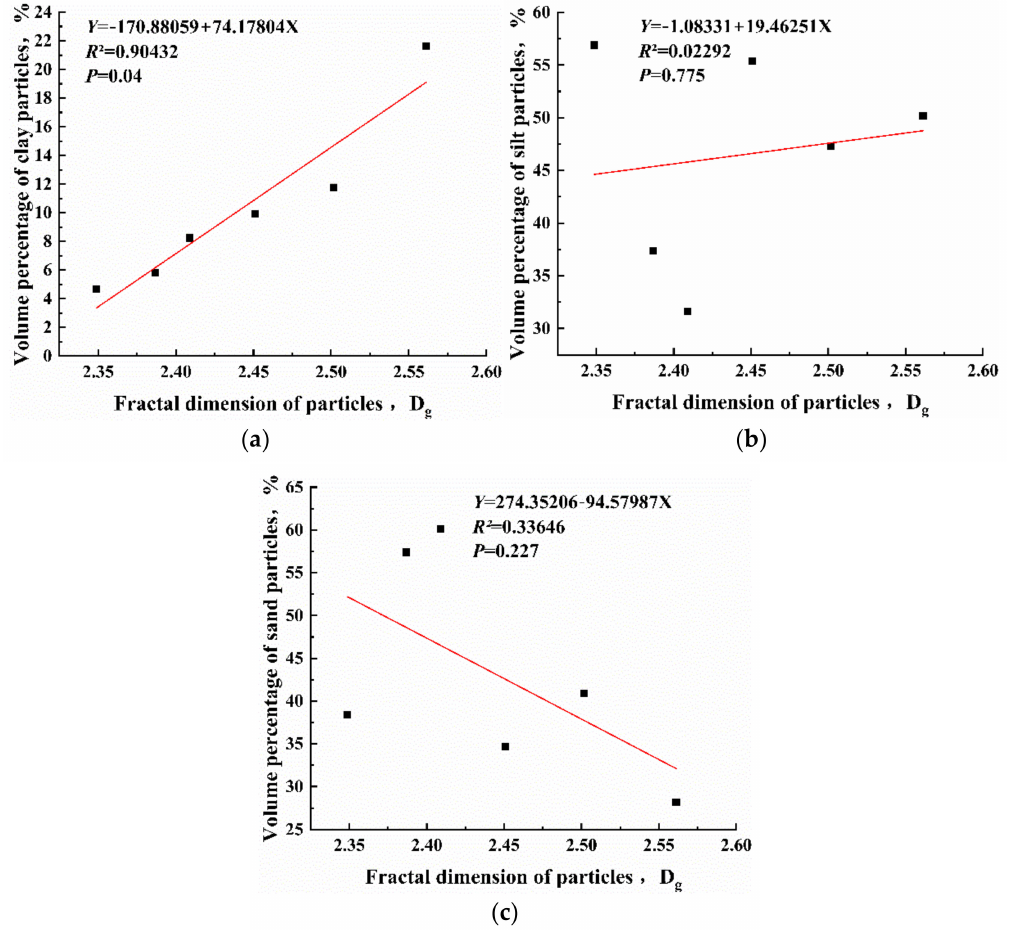
Figure 10. Correlation between volume percentage of soil different particles and fractal dimension of par-ticles: ( a ) Clay particles; ( b ) Silt particle; ( c ) Sand